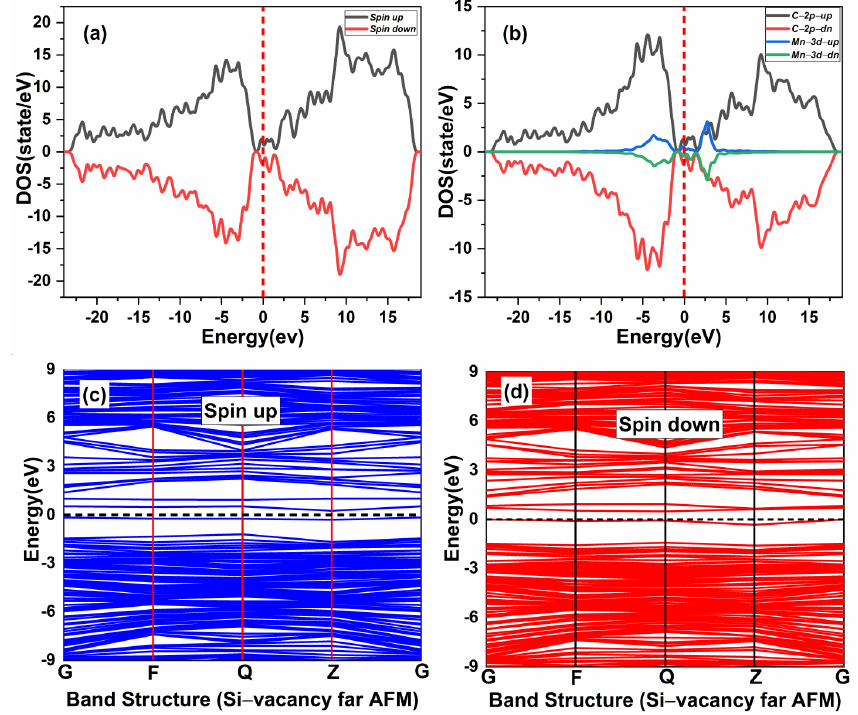
Figure 12. Spin-polarized ( a ) total density of state (TDOS) and ( b ) partial DOS of double (Mn +2 )- doped 3C-SiC Silicon-vacancy far AFM. ( c ) Blue Spin up and ( d ) red spin down of band Structure. Fermi Level indicated by a red and black dash line.